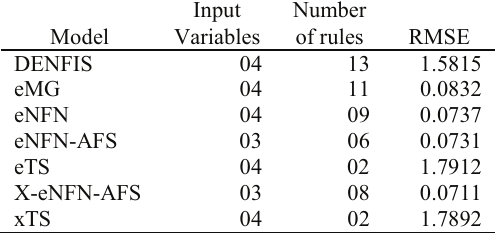
Table 1. Sphere position prediction